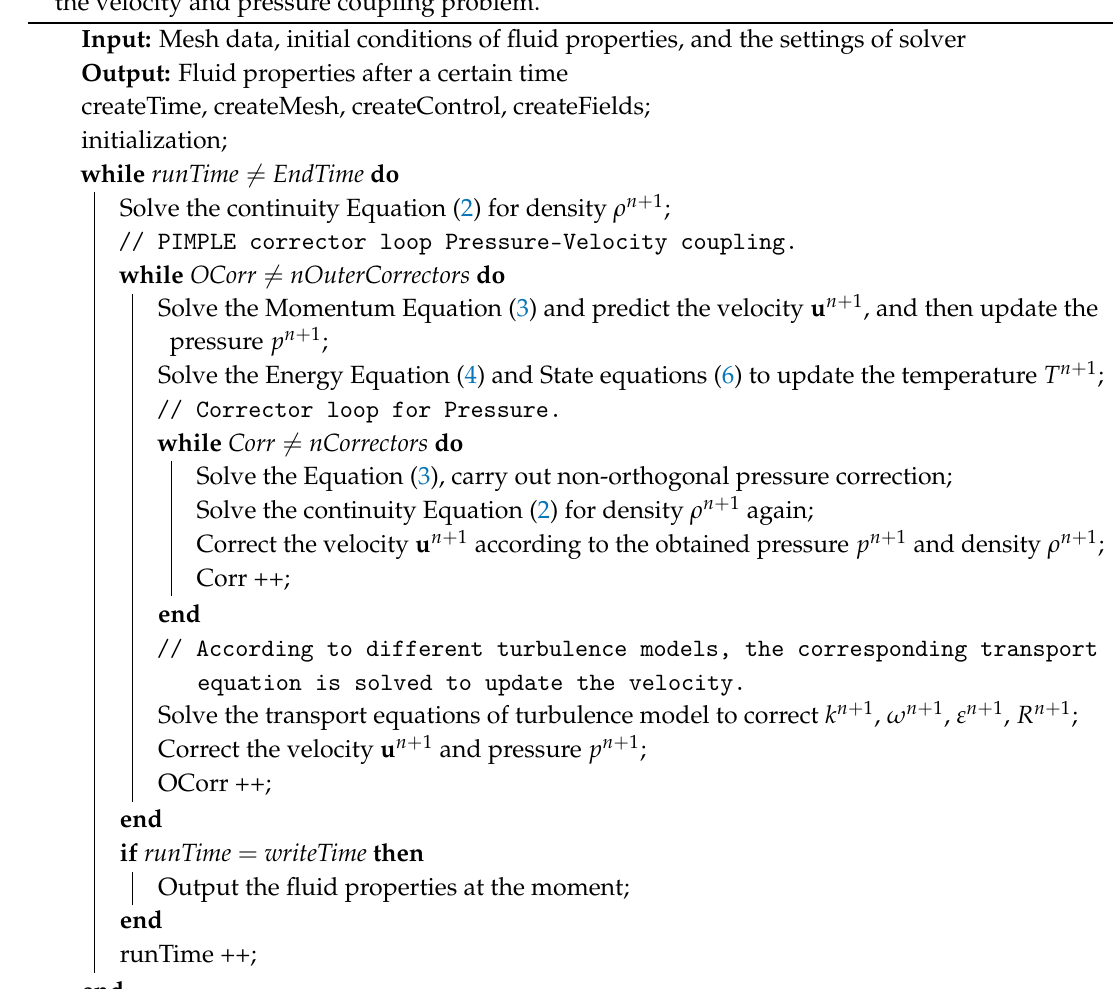
Algorithm 1: The numerical algorithm of PRTFOAM, which adopt the PIMPLE algorithm for the velocity and pressure coupling